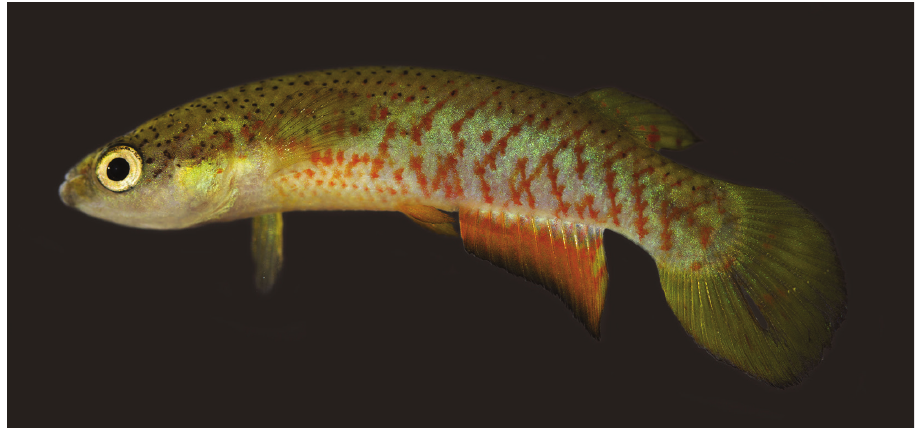
Figure 1. Melanorivulus ignescens sp. n., holotype, UFRJ 6875, male, 27.7 mm SL. Photograph by W.J.E.M.